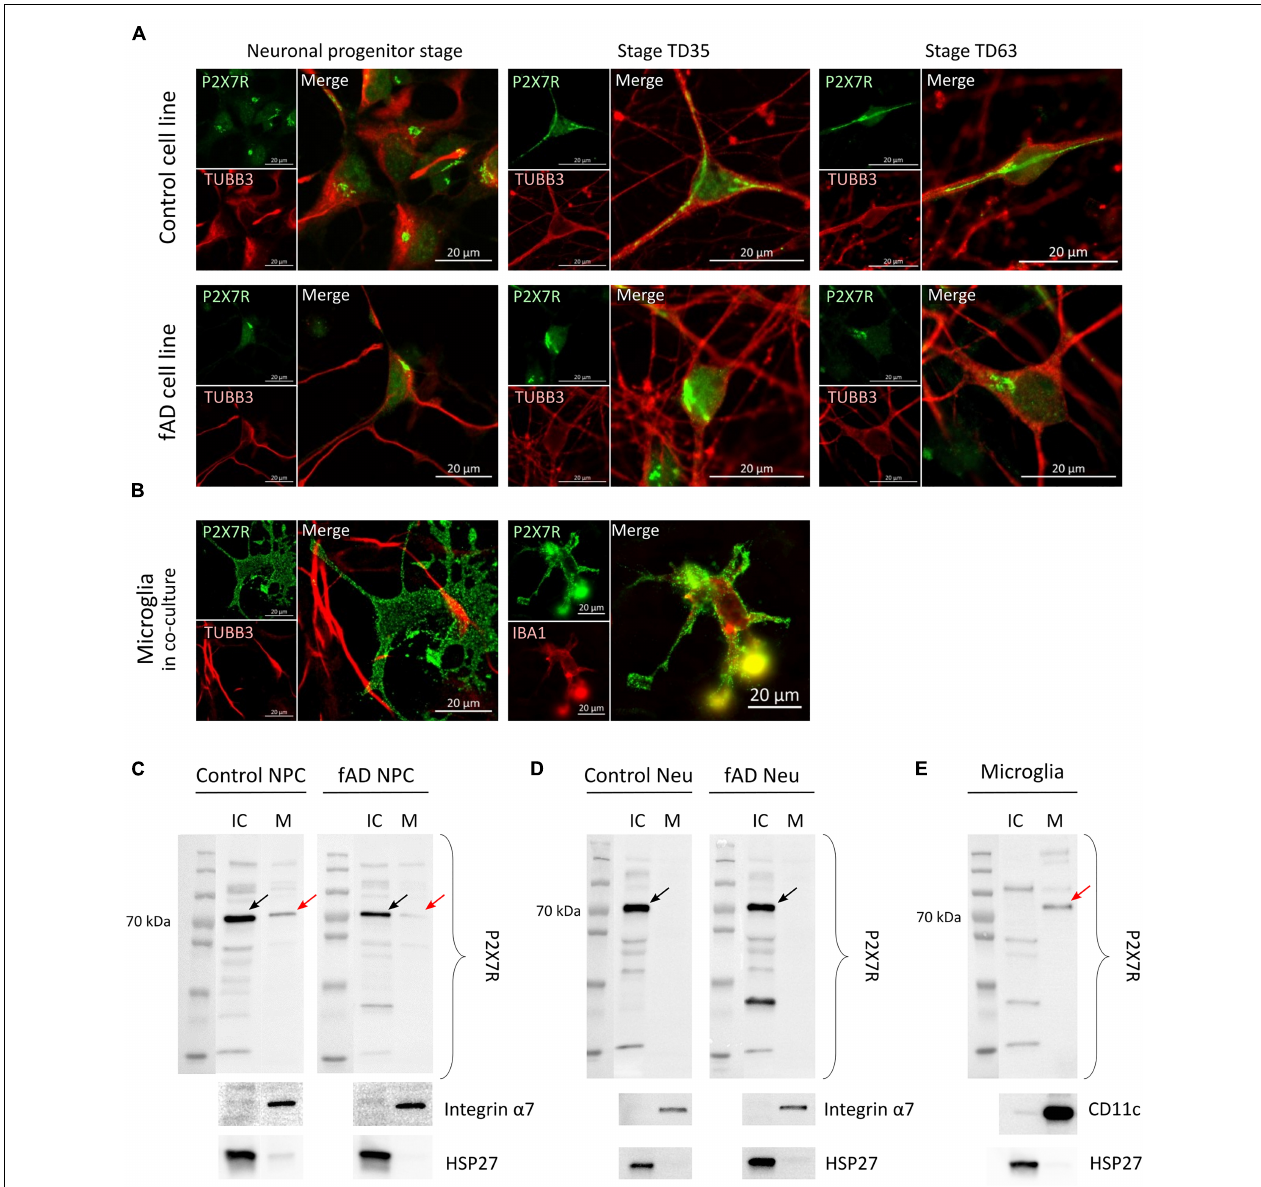
FIGURE 6 | Representative confocal images suggest intracellular localization of the P2X7 receptor’s signal (in green) in Ctrl and fAD neuronal cells (NPC or neurons; labeled with TUBB3 (in red) (A) and membranous localization in microglia-like cells (B) . Each staining is a representative picture of at least six independent experiments. Microglia-like cells were co-stained with IBA1 (red). Scale bar: 20 µ m (C,D) and (E) show representative Western blot results of biotinylation analysis. Arrows indicate the bands representing the canonical ≈ 72 kDa sized P2X7R localized in the IC (intra-cellular) fraction in the case of Ctrl and fAD neurons’ (TD53) samples (D) and the M (membrane) fraction of microglia samples (E) and both fractions in NPC samples (C) . Red arrows indicate the presence of the P2X7R band in the M fractions. The Integrin α 7 (C,D) and CD11c (E) are plasma membrane proteins present only in the M factions. HSP27 is a nuclear protein present only in the IC fractions (C–E) . Integrin α 7 and HSP27 were used as controls of the efficiency of biotinylation and the separation of biotinylated proteins. Western blot measurements were per-formed as biological triplicates and a duplicate in the case of microglia-like cells. Ctrl, control; Neu, neuron; NPC, neuronal progenitor cell; IC, intra-cellular; M,